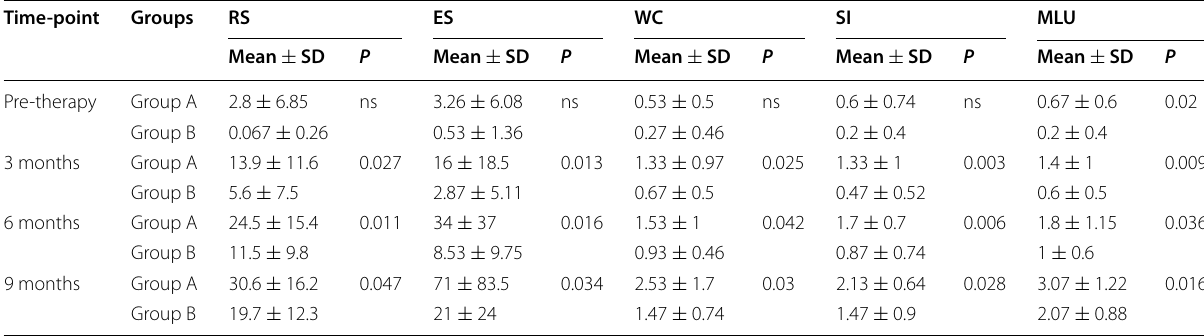
Table 5 shows the means, standard deviation (SD), and P -values of the comparisons between language parameters in both